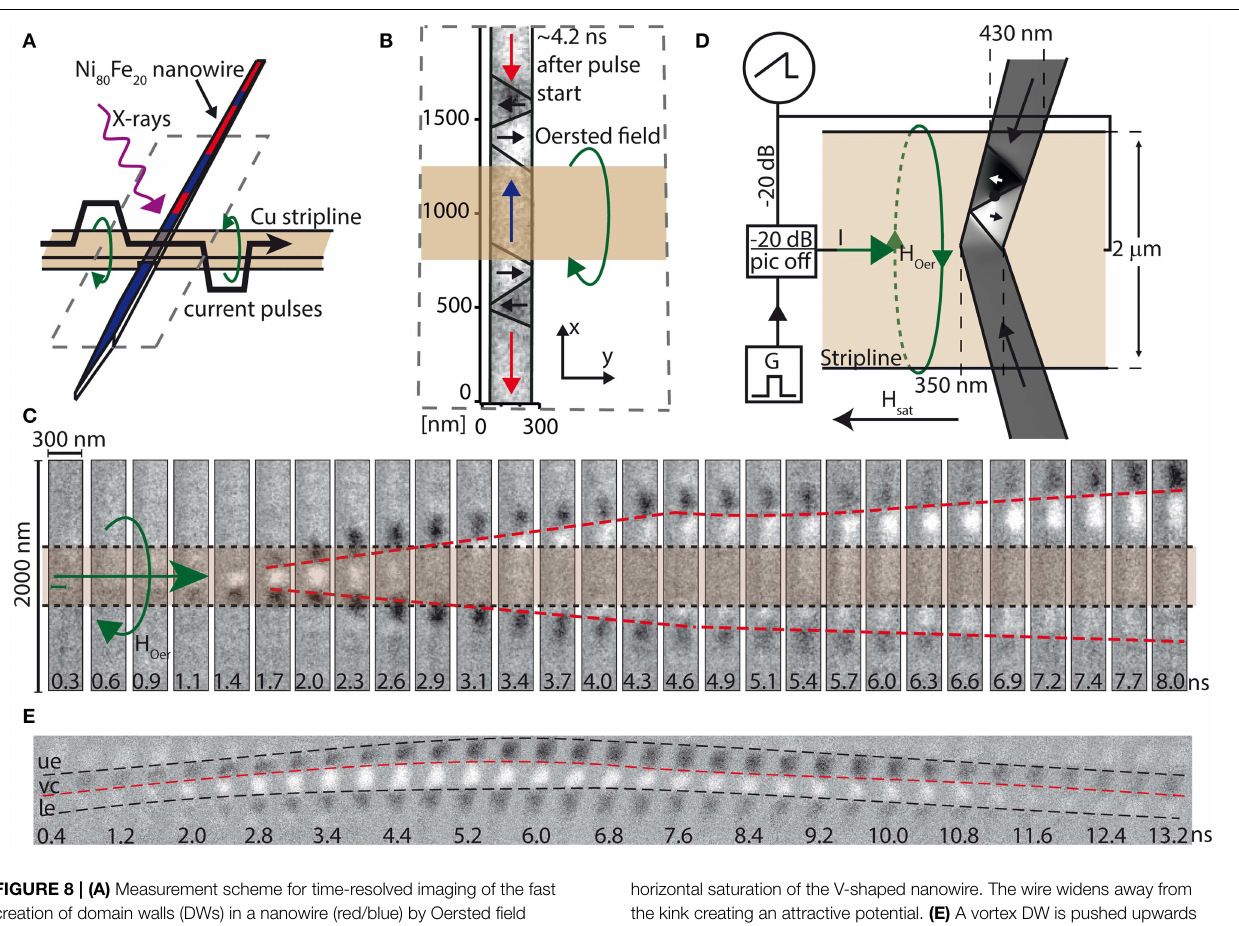
FIGURE 8 | (A) Measurement scheme for time-resolved imaging of the fast creation of domain walls (DWs) in a nanowire (red/blue) by Oersted field pulses (green) around a stripline (beige). The imaged area is depicted in (B) showing two vortex DWs with a black/white contrast. (C) Fast creation of two vortex DWs undergoing structural transformations by a 6ns long 60mT field pulse. (D) Scheme for low field motion imaging. The wall is injected by